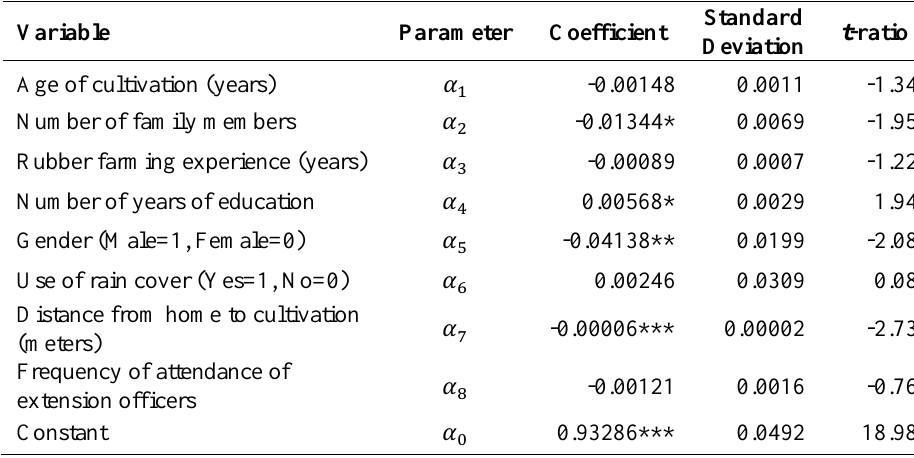
Table 6: Technical Efficiency Criteria Related to the Tobit Model (Dependent Variable = TE)